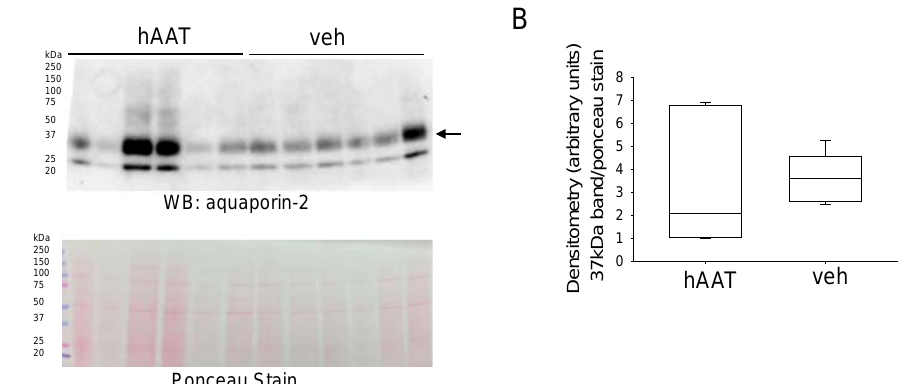
Figure 7. Western blot and densitometric analysis of aquaporin-2 protein expression in the hyperten- sive diabetic kidney. ( A ). Western blot for aquaporin-2 protein expression. Eighty micrograms of total protein from kidney cortex lysates from hypertensive diabetic db/db mice treated with either hAAT or vehicle were resolved by SDS-PAGE and then transferred to nitrocellulose membranes which were blotted for aquaporin-2 protein expression. ( B ). Image J was used to obtain densitometry values for each band which were normalized to the Ponceau staining. N = 6 mice in each